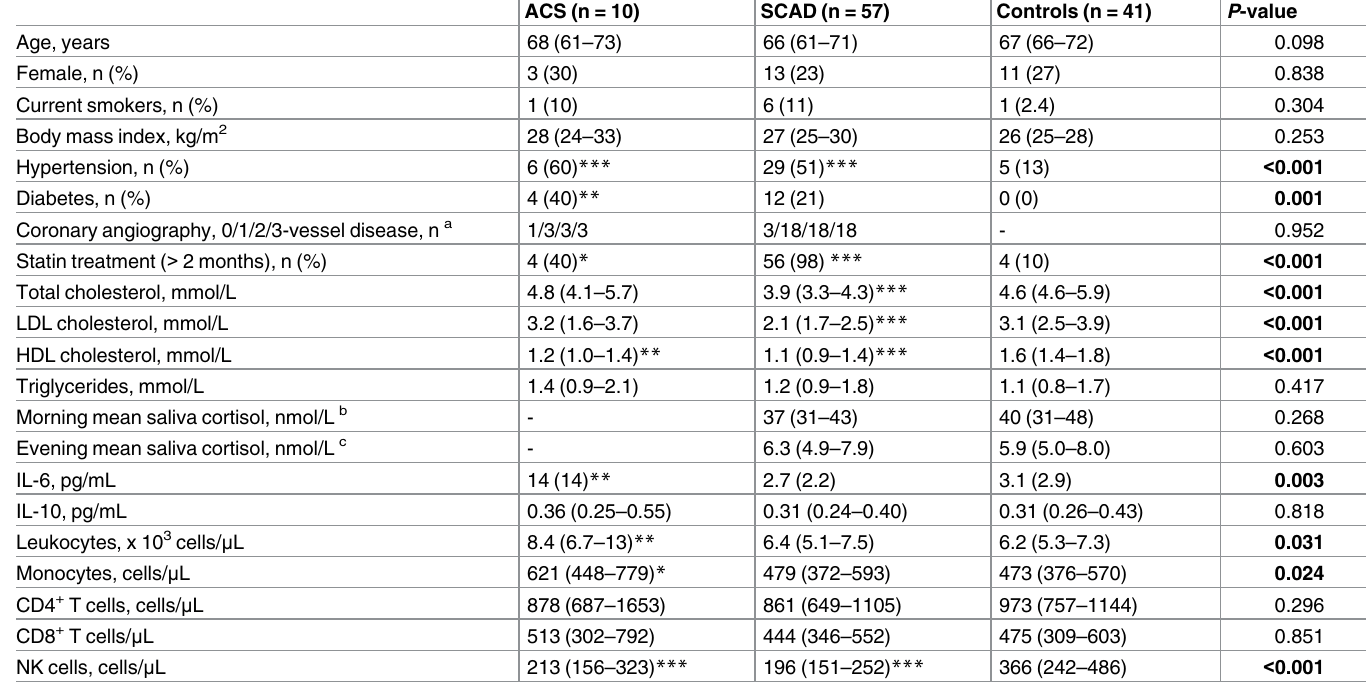
Table 1. Characteristics of ACS patients, SCAD patients and